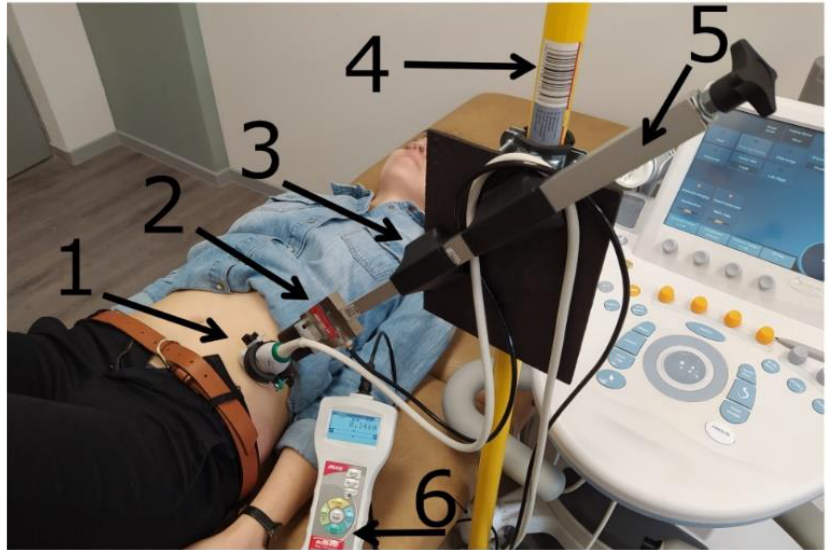
Figure 1. General overview of the setup for the ultrasound examination with probe compression controlled. 1. Ultrasound probe. 2. External S-Type load cell connected to a force gauge (6). 3. Two-dimensional magnetic holder. 4. An expansion beam. 5. Precise screw actuator.